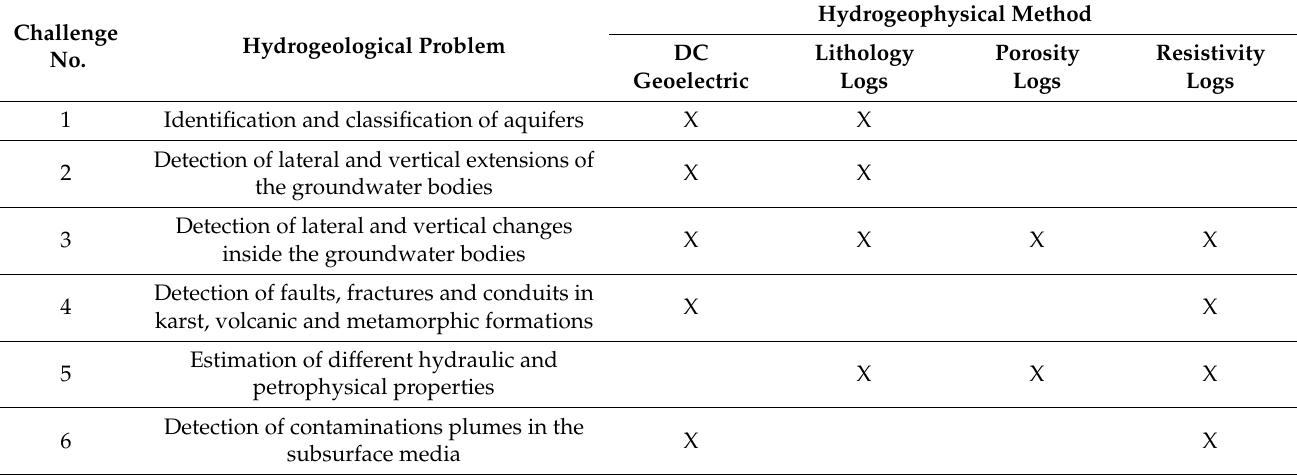
Table 1. Challenges in the investigation of Hungarian groundwater bodies and their solution by the best applicable (X) geophysical methods. Challenge